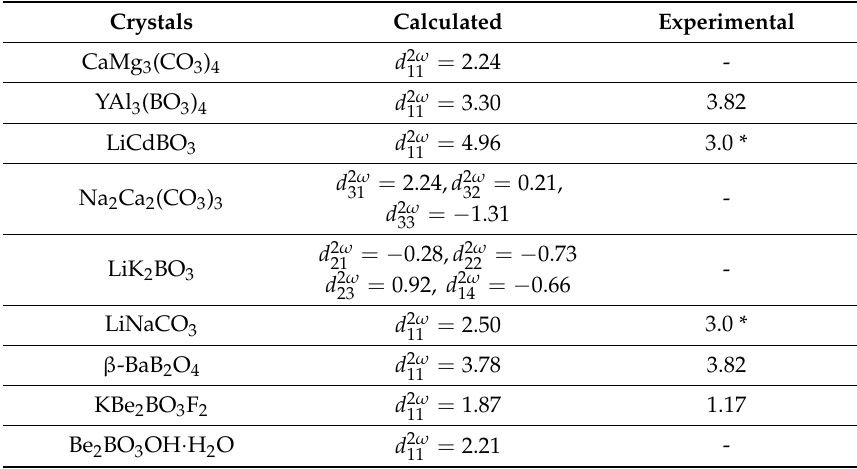
Table 2. Calculated SHG coefficients of selected crystals with isolated anionic groups (in unit: 10 − 9 esu, conversion factor: 1 esu = 4 π /3 × 10 − 4